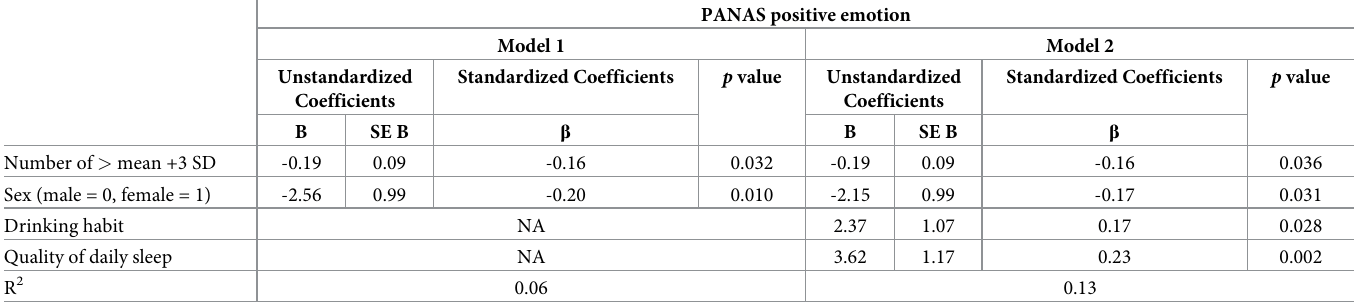
Table 4. Effect of the LF/HF ratio on positive